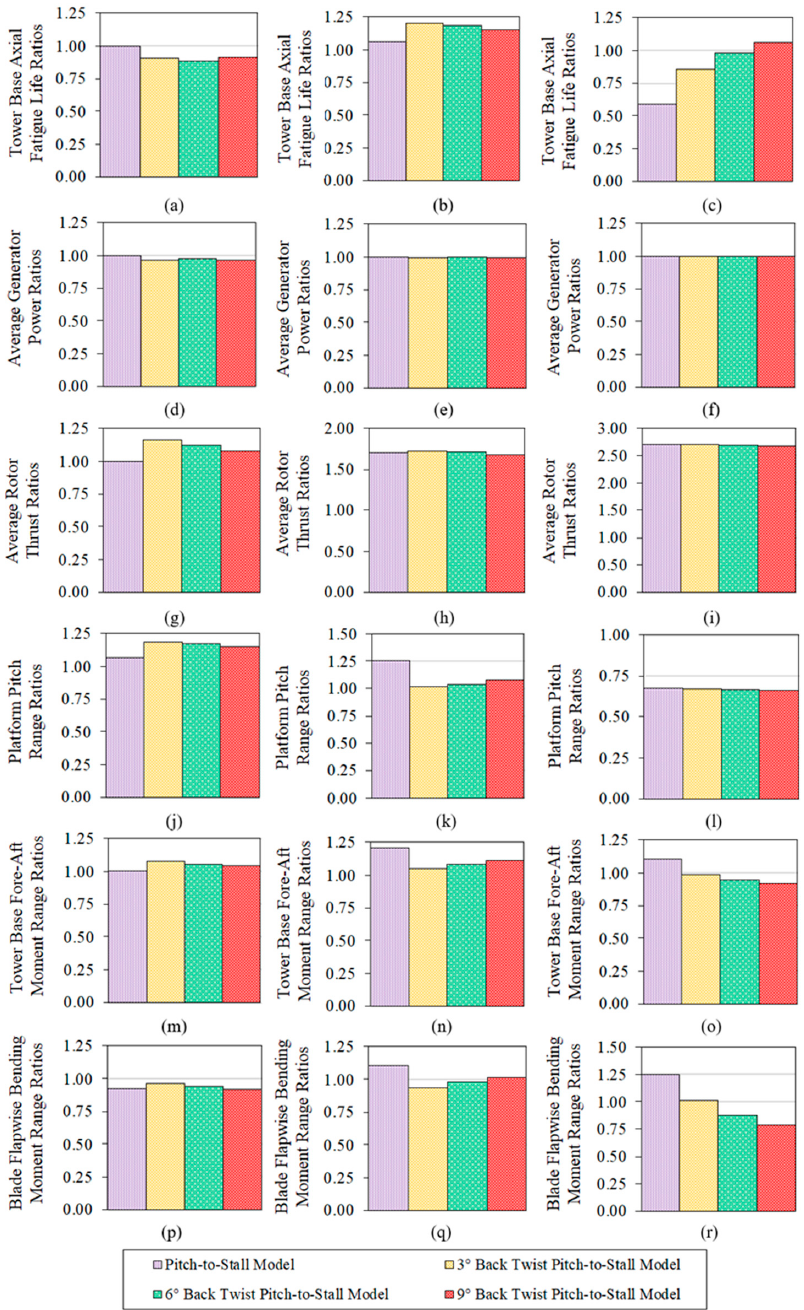
Figure 6. Simulation outputs for pitch-to-stall blade models with and without back twist. Outputs were normalized against the “Feather Base Model” and given for 8 (left), 13 (center), and 18 m/s (right) mean turbulent winds. ( a ) tower base axial fatigue life ratios (TBAFLR)(8mps); ( b ) (TBAFLR) (13mps); ( c ) (TBAFLR) (18mps); ( d ) average generator power ratios (AGPR) (8mps); ( e ) AGPR (13mps); ( f ) AGPR (18mps); ( g ) average rotor thrust ratios (ARTR) (8mps); ( h ) ARTR (13mps); ( i ) ARTR (18mps); ( j ) platform pitch range ratios (PPRR) (8mps); ( k ) PPRR (13mps); ( l ) PPRR (18mps); ( m ) tower base fore-aft moment range ratios (TBFARR) (8mps); ( n ) TBFARR (13mps); ( o ) TBFARR (18mps); ( p ) blade flapwise bending moment range ratios (BFBMRR) (8mps); ( q ) BFBMRR (13mps); ( r ) BFBMRR (18mps).